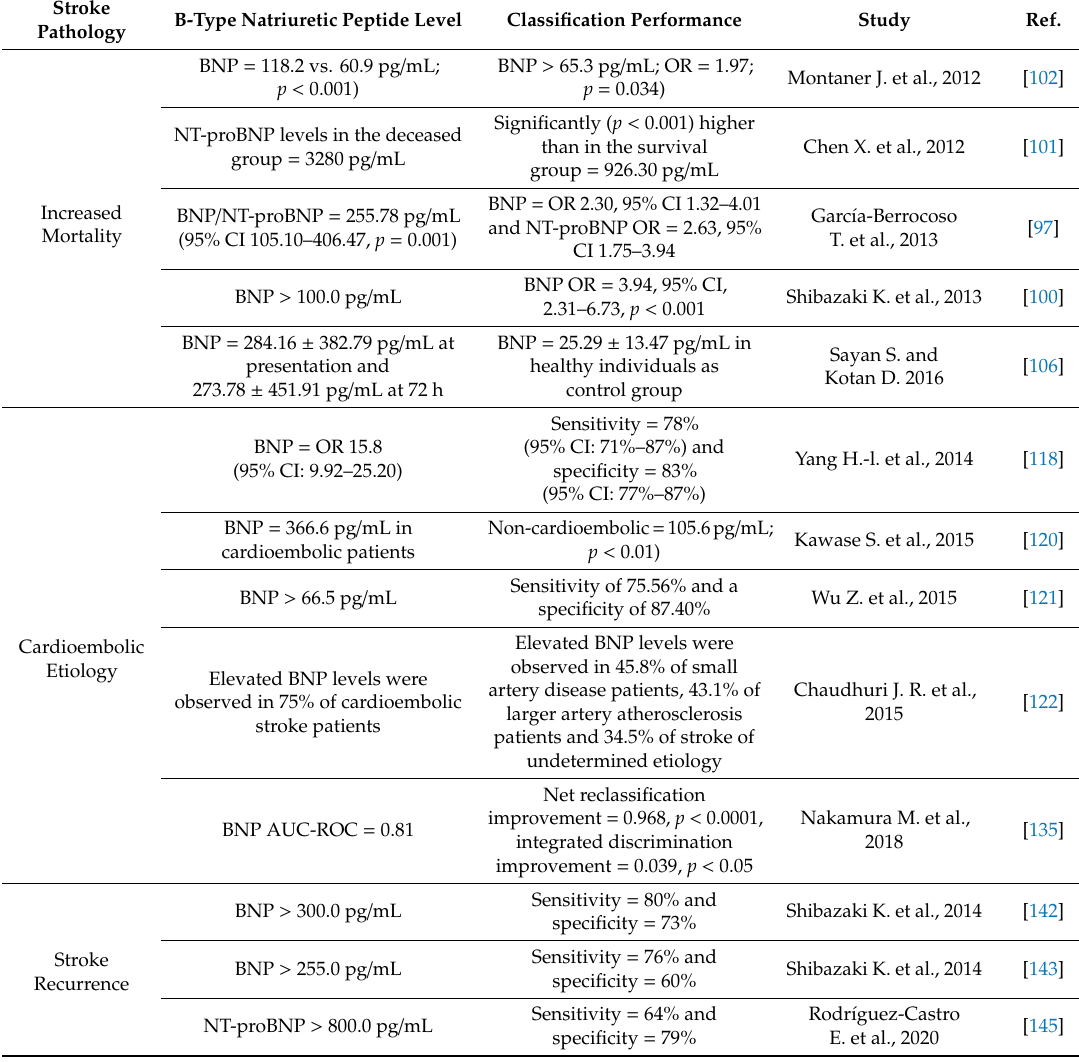
Table 1. B-type natriuretic peptide association in stroke